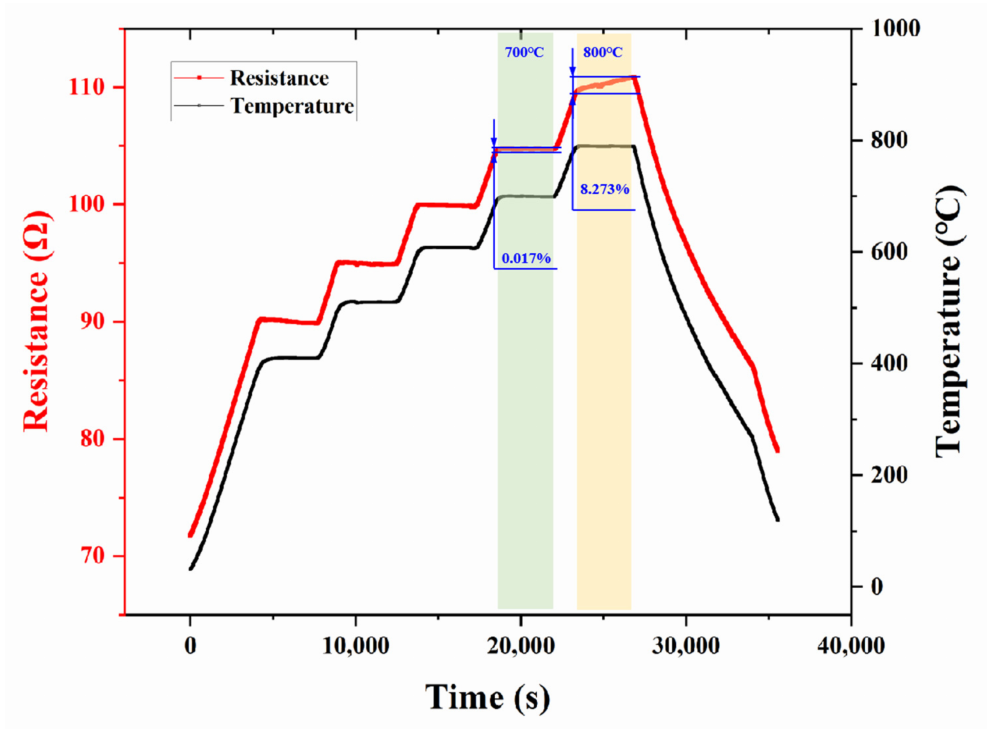
Figure 7. Resistance changes curves of Pt TFSGs at different temperatures.